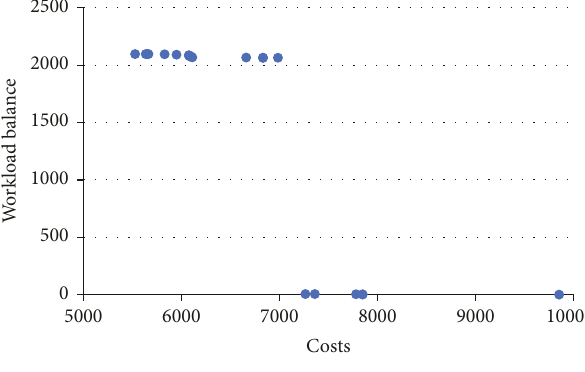
Figure 6: Approximation of the Pareto front of Instance 5.